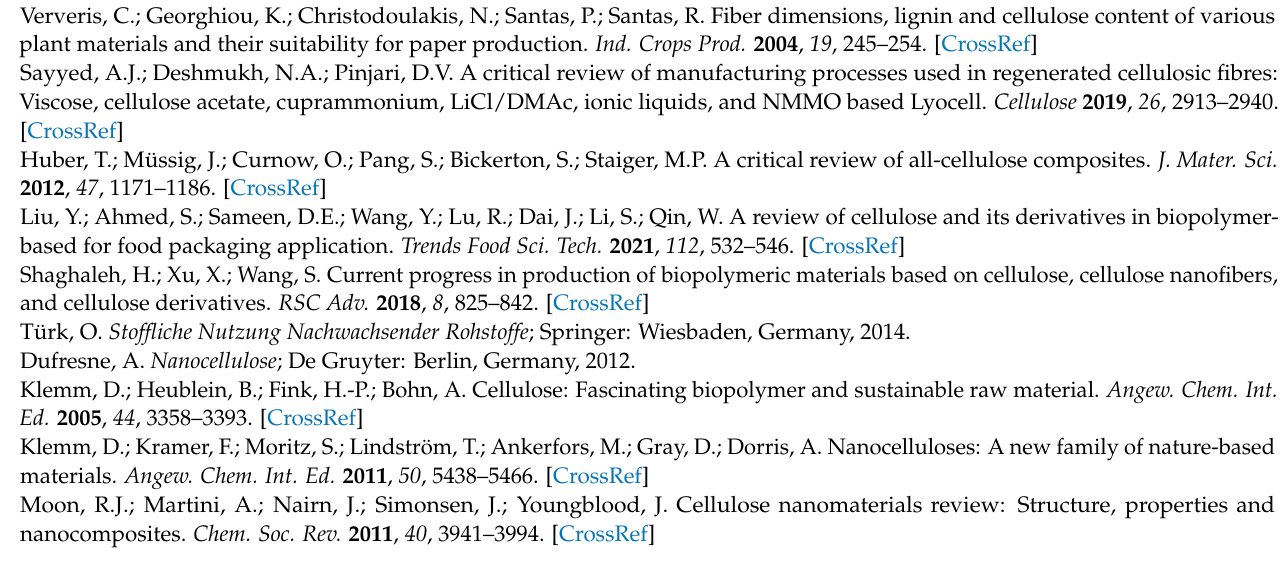
separation of the CNC samples. Table S2: pH values at different steps of the synthesis of CNC- APTES. Table S3: Concentrations of FITC in washing water (CNC-APTES-FITC-3). Table S4: Detailed description of IR modes of CNC, CNC-APTES-3 and CNC-ATPES-FITC-3. Figure S1: Relation between combustion residue (wt.%) of CNC-APTES and DoS. Figure S2: Fractograms of triplicate separation of polystyrene beads (size standards with D = 62 nm ± 4 nm, NanoSphere TM 3060A Thermo Scientific TM ). Retention time of the peak maximum was used to determine the effective channel height = 331.41 µ m ± 0.13 µ m. Figure S3: (a) Titration of APTES with HCl 0.5 mol L − 1 . (b) Titration of CNCs with NaOH 0.1 mol L − 1 (negative x axis) and HCl 0.1 mol L − 1 (positive x axis). Figure S4: pH values at different steps of the synthesis of CNC-APTES. Figure S5: Calibration of FITC in buffer for photometry (at 495 nm). Figure S6: Spectrum of CNC non-modified and